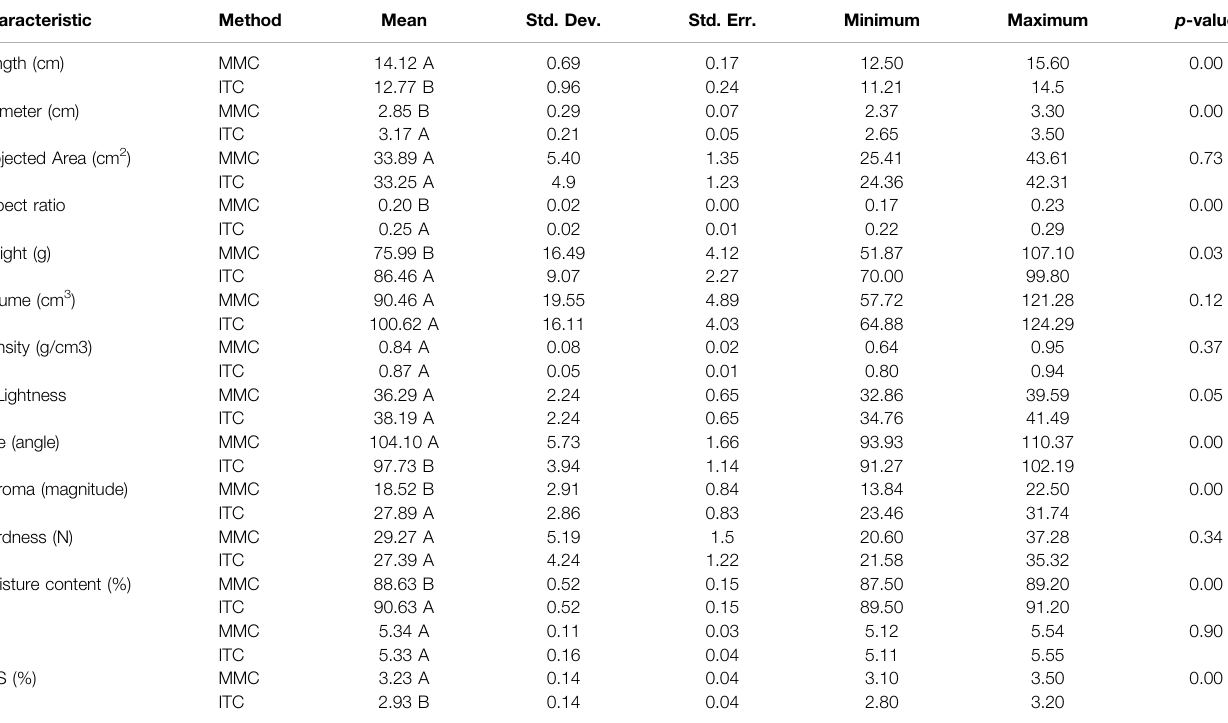
TABLE 3 | Improvements in the physical parameters of plants in a greenhouse fi tted with an automated water control system of medium moisture control (MMC) and irrigation timing (ITC) intelligent systems (Sagheer et al., 2020). Characteristic Method Mean Std.